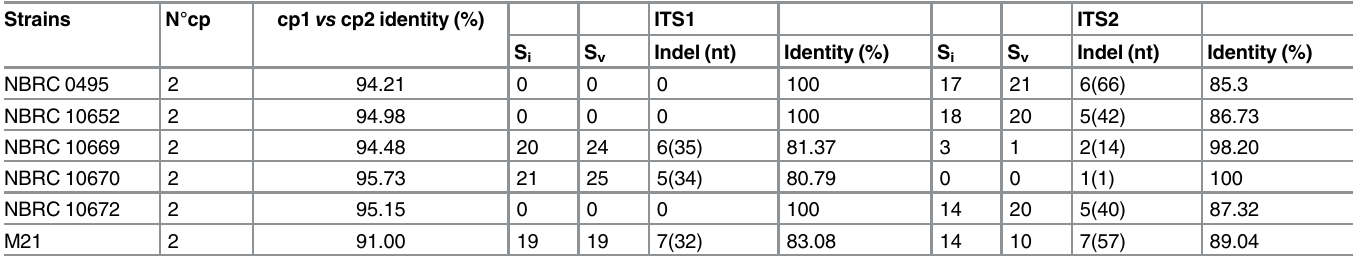
Table 2. Pairwise comparisons between intra-genomic ITS1 and ITS2 variants cloned from each strain. Numbers of transition (s i ) and transversion (s v ), as well as the number of indels are computed in pairwise comparisons between copies 1 and 2 of ITS1 and ITS2 segments with MEGA6. The total num- ber of nucleotides in indels is reported in brackets. Identity (%) indicates percentage of identical nucleotides between copies 1 and 2 of full-length ITS region or ITS1/ITS2 segments scored within each strain. Abbreviation: cp,